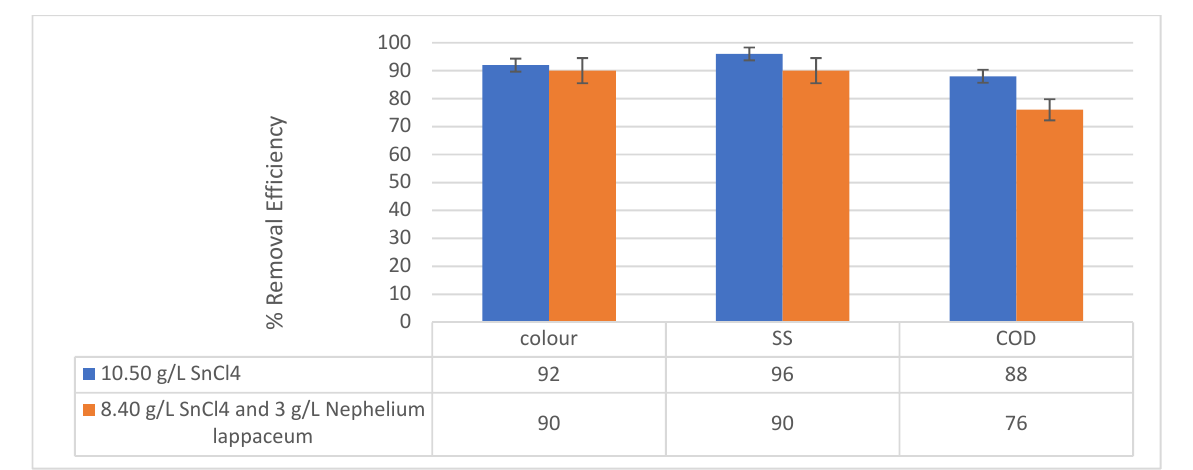
Figure 10. Removal efficiencies of pollutants at pH 7 with varied dosages of SnCl 4 as coagulant and Nephelium lappaceum seed as a flocculant. ( a ) Colour; ( b ) Suspended solids (SS); ( c ) COD.